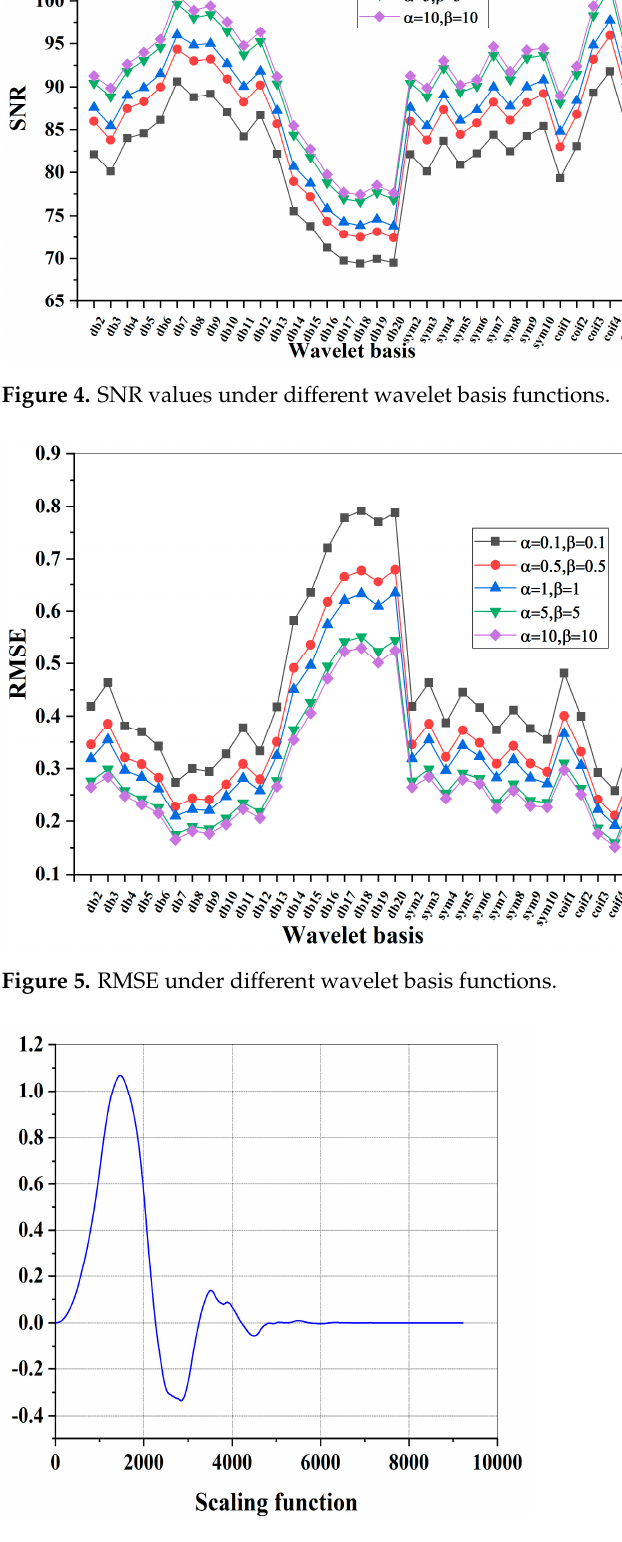
Figure 7. Wavelet function. 3.2. Determination of Decomposition Levels For the selection of discrete wavelet decomposition layer, there is no systematic study and no strict basis for partitioning. Therefore, researchers need to try according to the